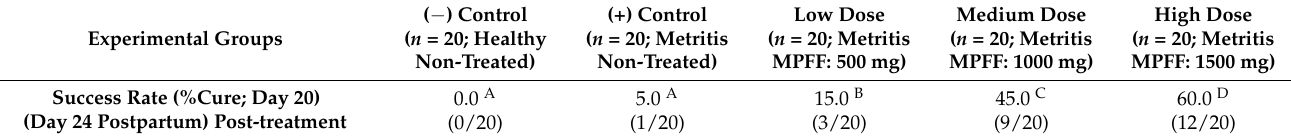
Table 1. Effects of intrauterine infusion of Micronised Purified Flavonoid Fraction (MPFF; low, medium and high concentrations) on the success rate (% cure) at day 20 (day 24 postpartum) in metritis-diagnosed dairy cows naturally infected by E. coli during the early postpartum